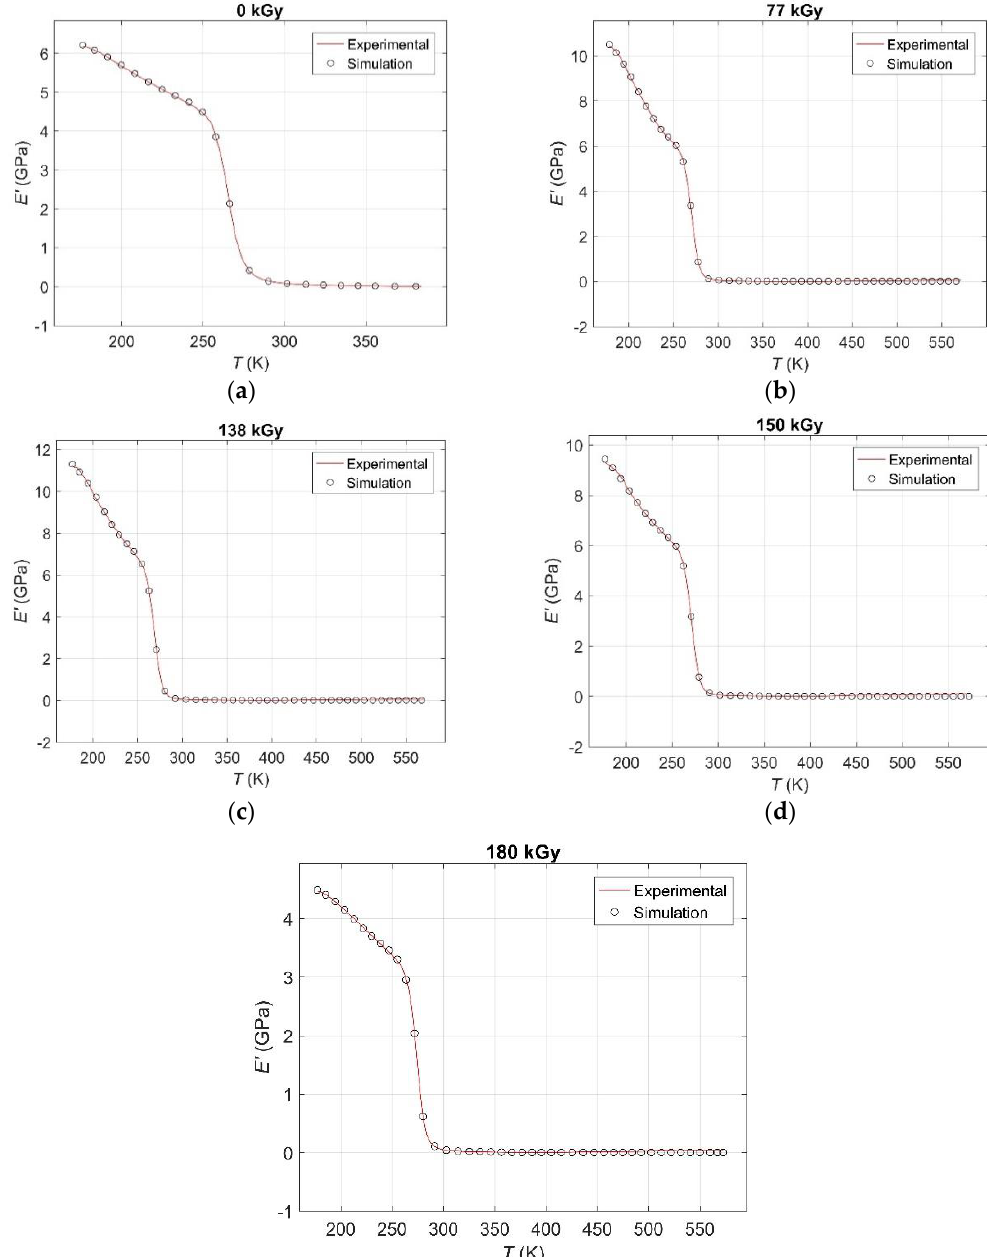
Figure 3. The results of curve fitting by GA compared to the corresponding experimental log( E′ ( T,d )) curves in the temperature range until the onset temperature of the additional thermally-induced polymerisation for: ( a ) an unirradiated sample; ( b ) for a radiation dose of 77 kGy; ( c ) for a radiation dose of 138 kGy; ( d ) for a radiation dose of 150 kGy; ( e ) for a radiation dose of 180 kGy.